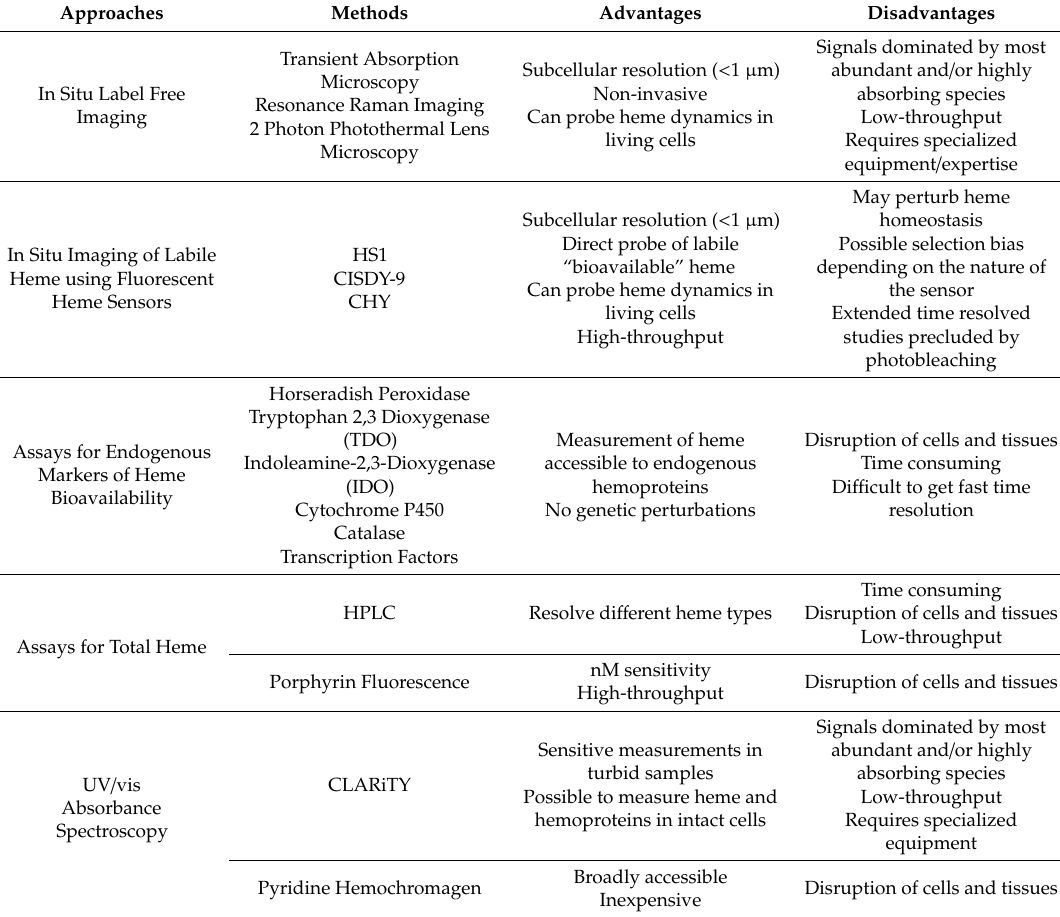
Table 2. Approaches to measure total and labile heme in cells and tissues. References are in the